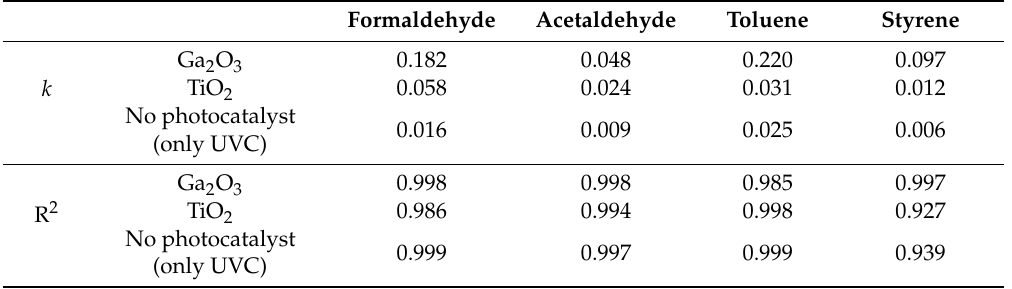
O , TiO , and no catalyst 2 3 2 O , TiO , and no 2 3 2 O over TiO as a function of dissociation energy of 2 3 2 different VOCs.